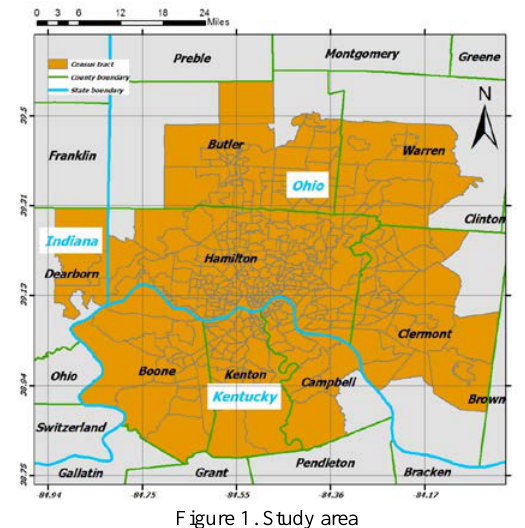
Figure 1. Study area